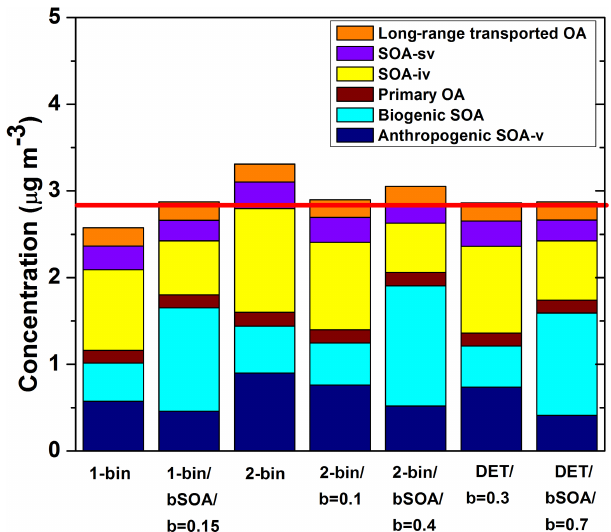
Figure 5. Predicted OA composition for the schemes with good per- formance for San Pietro Capofiume. The red line indicates the aver- age ground-measured OA equal to 2.8µgm − 3